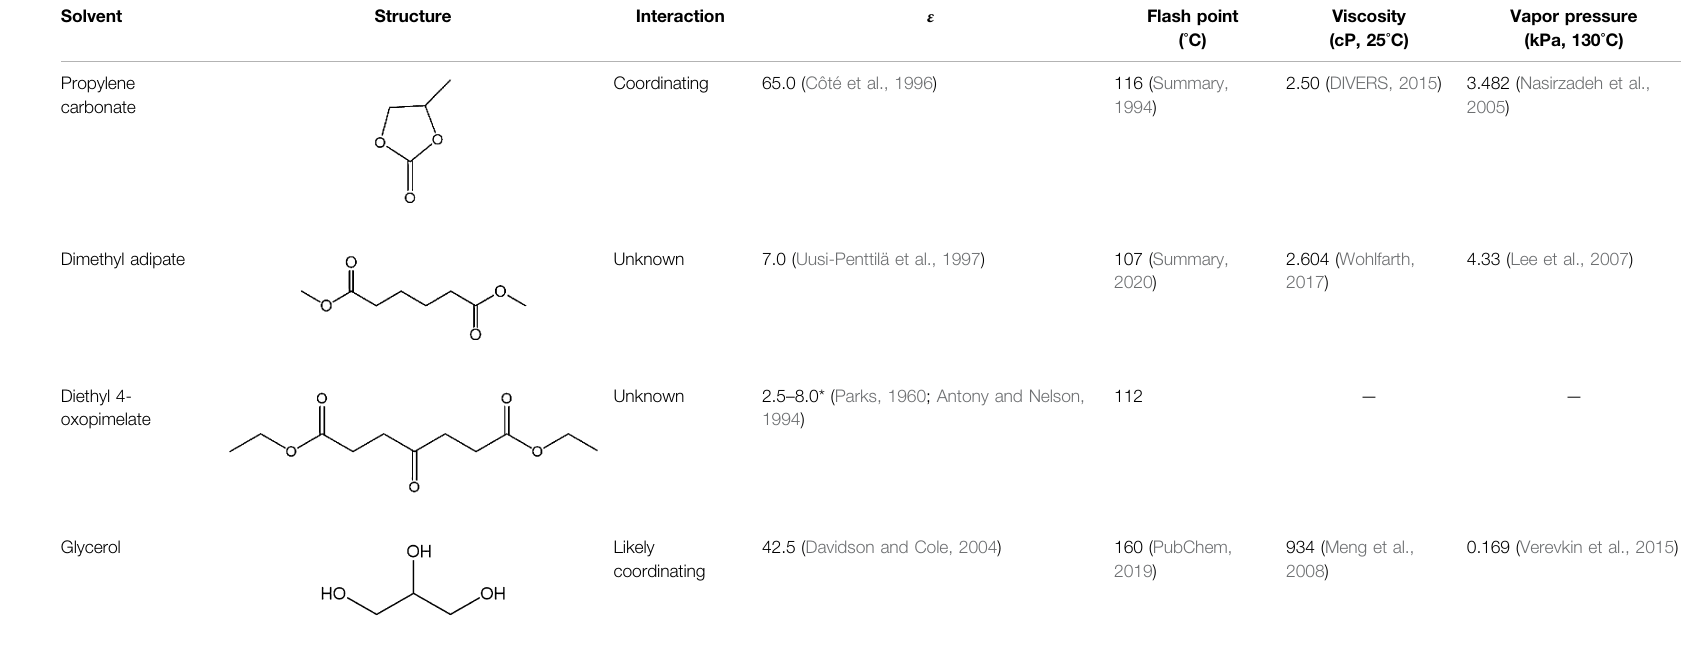
TABLE 1 | Physical properties of the solvents investigated in this study and their proposed interaction with sodium